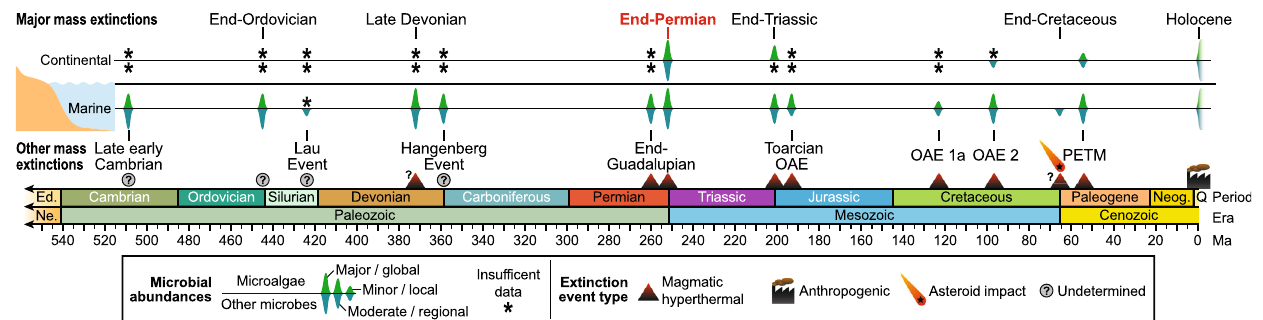
Fig. 6 Phanerozoic mass extinctions with evidence of increased microbial abundances. Inferred minor/local or moderate/regional microbial abundances may be in part due to inadequate data coverage. Extinction event types from ref. 59 . Data sources: late early Cambrian (c. 509 Ma) 63,85,86 ;